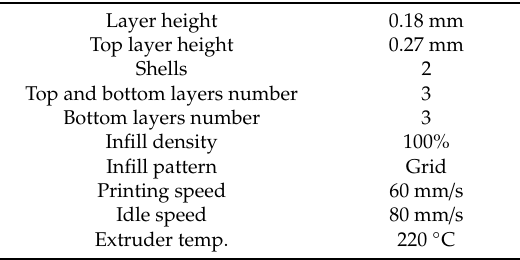
Table 4. Process parameters for sample printing.